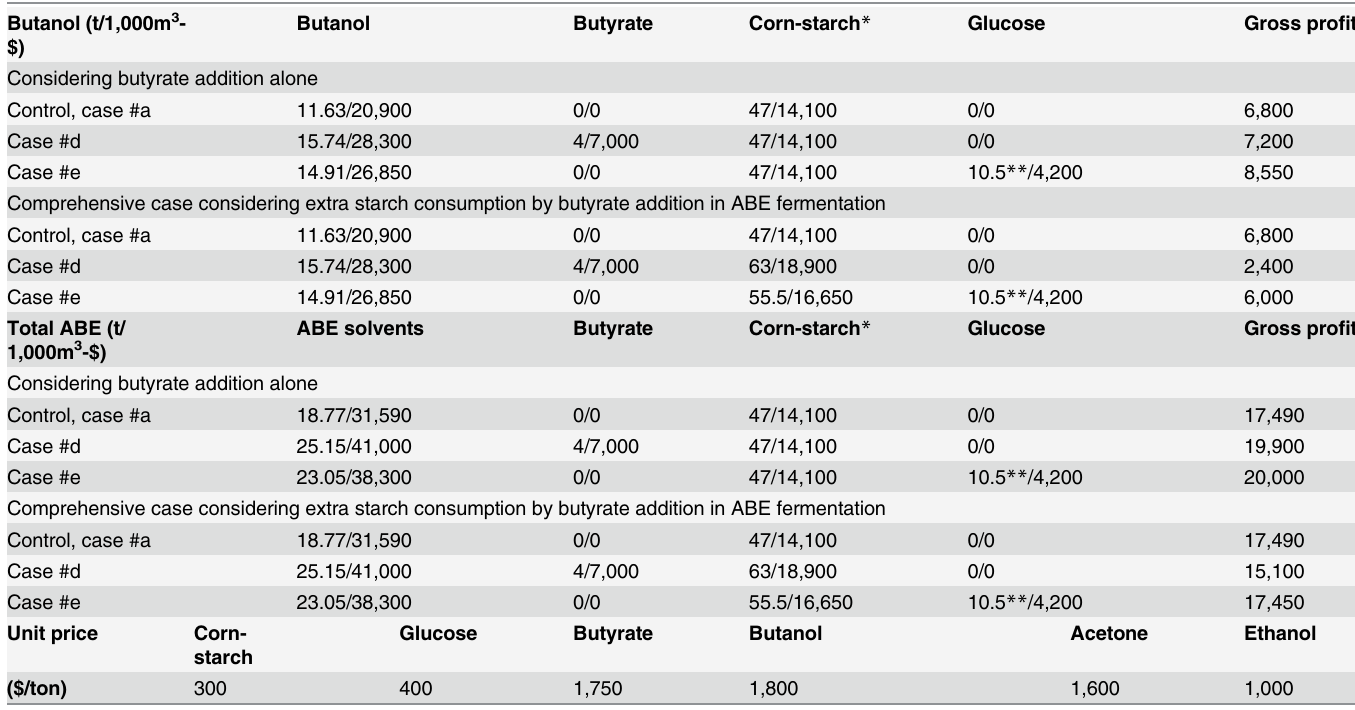
Table 3. Economical evaluation of the proposed fermentation strategy using synthetic butyrate and butyrate fermentative supernatant. Butanol (t/1,000m 3